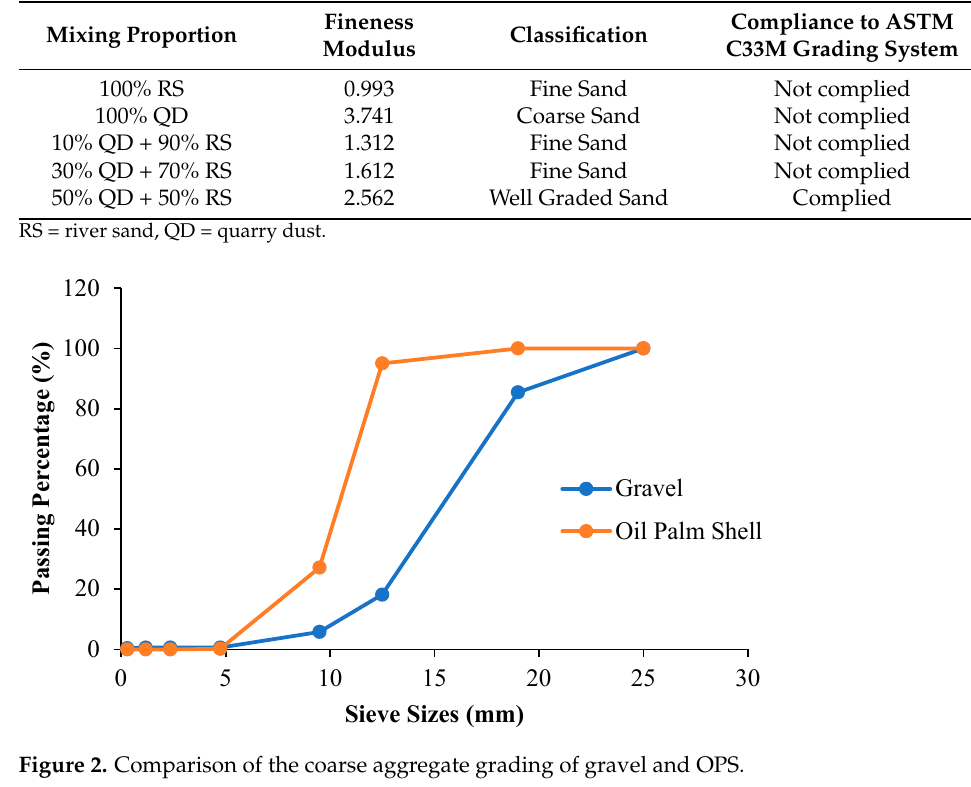
Table 2. Fineness modulus and classification of fine aggregate.